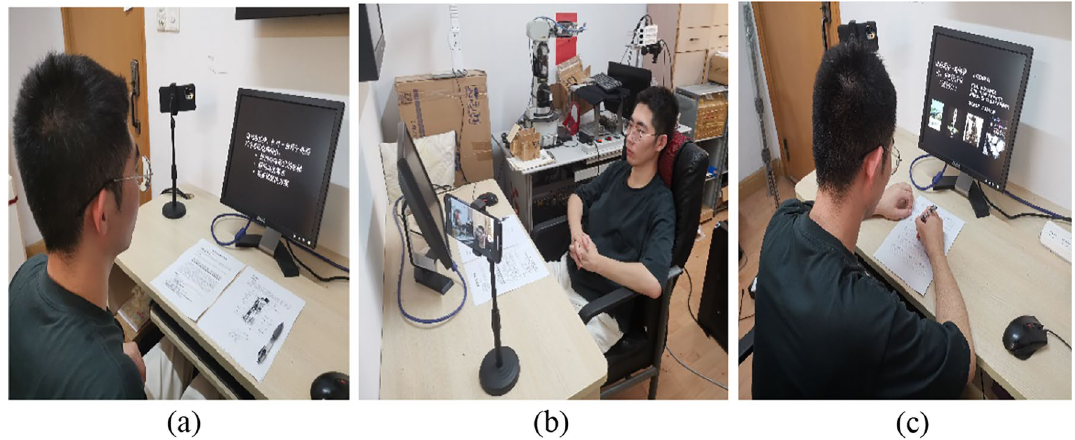
Figure 4. The experimental environment and process: ( a ) experiment preparation, ( b ) requirement statement, ( c ) evaluation and discussion.